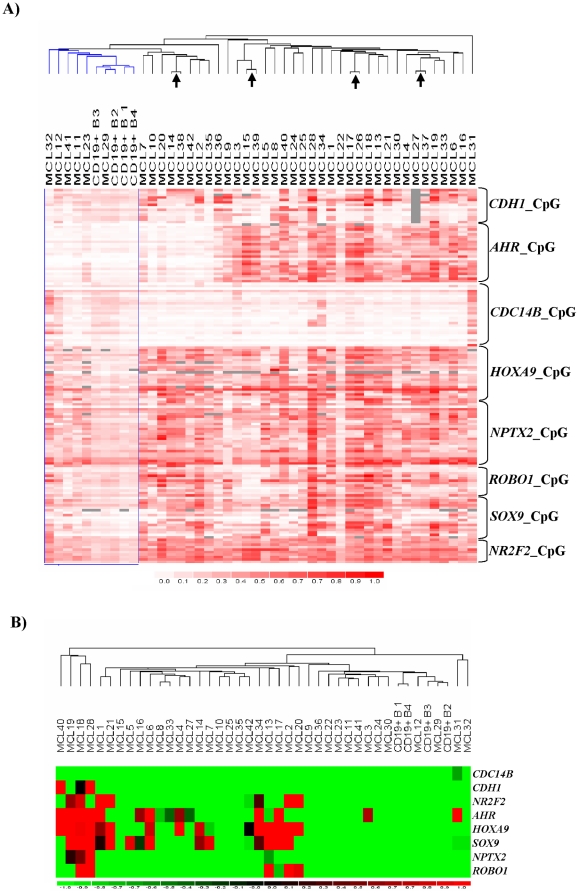
CpG methylation in primary MCL.A) Hierarchical clustering of MCL samples and normal CD19+ B cells. Row methylation values are represented in a heat map, unmethylation (white) and full methylation (red). Blue colour highlights the cluster containing the four normal samples. The black arrows indicate the four duplicate DNA samples. B) Values represent the summary of the CpG unit methylation data for each gene. The samples were clustered using the data standardized for the cut-off used to define gene methylation.